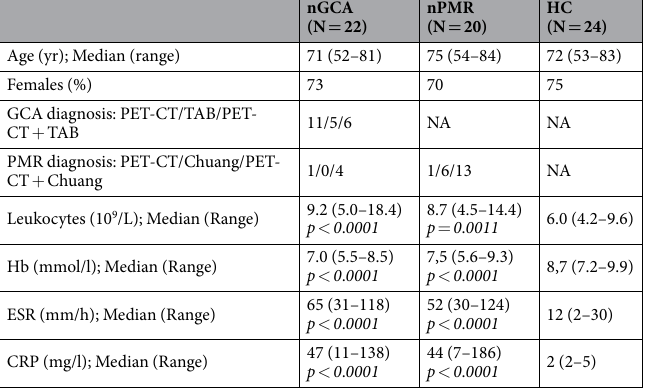
Table 1. Baseline characteristics of patients and controls in the peripheral blood study. Characteristics of newly diagnosed glucocorticoid/DMARD-free GCA (nGCA) and PMR patients (nPMR) and of healthy controls (HC). Five out of 22 GCA patients also had PMR. In 14 out of 20 PMR patients LV-GCA was excluded based on PET-CT. Importantly, the diagnosis of PMR did not change into GCA during a minimal follow-up of 6 months. The Kruskal-Wallis test was performed to compare data among the three study groups. The Mann-Whitney U test was used to compare each patient group with HC. P-values of less than 0.05 (2-tailed) were considered statistically significant. Yr = years. PET-CT = positron emission tomography-computed tomography. TAB = temporal artery biopsy. Hb = haemoglobin, ESR = erythrocyte sedimentation rate. CRP = C-reactive protein. NA = not